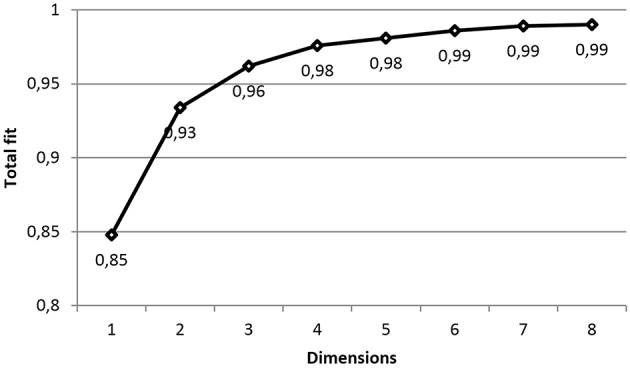
Scree plot. Total fit calculated according to Busing et al. (1997).